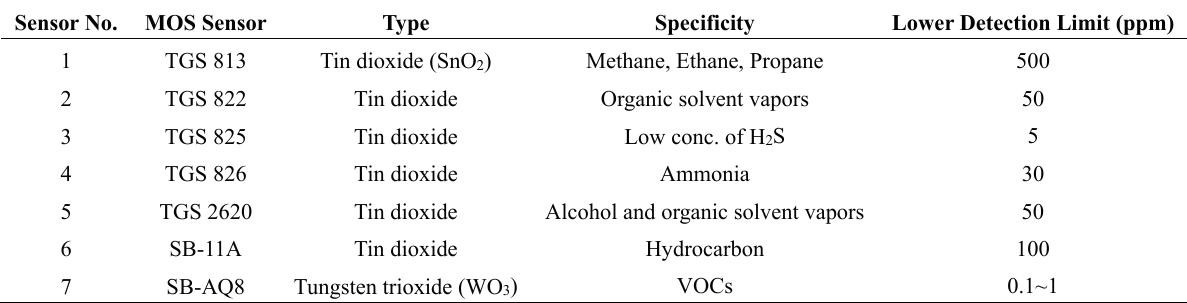
Table 1. List of MOS sensors used to build gas sensor array, their gas specificity and manufacturer’s reported lower detection limit. Sensors 1–5 were purchased from FIGARO Inc. and sensors 6 and 7 from FIS